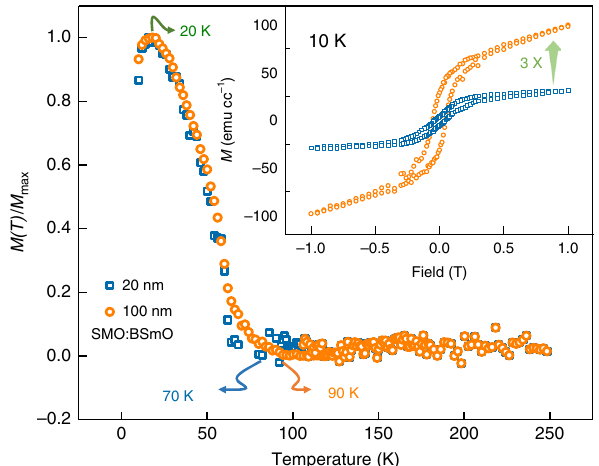
Fig. 3 Magnetic properties of 20 nm and 100 nm thick VAN SMO:BSO fi lms. Main panel shows normalised in-plane fi eld cooled M ( T ) at a fi eld of 20 mT. The T C,FM values are ~70 K and ~90 K for the 20 nm and 100 nm thick VAN fi lms, respectively. The inset shows MH loops for the 20 nm and 100 nm fi lms, respectively, at 10 K, measured with fi eld range ±1 T, with the fi eld applied in-plane. The MH loops show that the volume magnetisation increases as the thickness